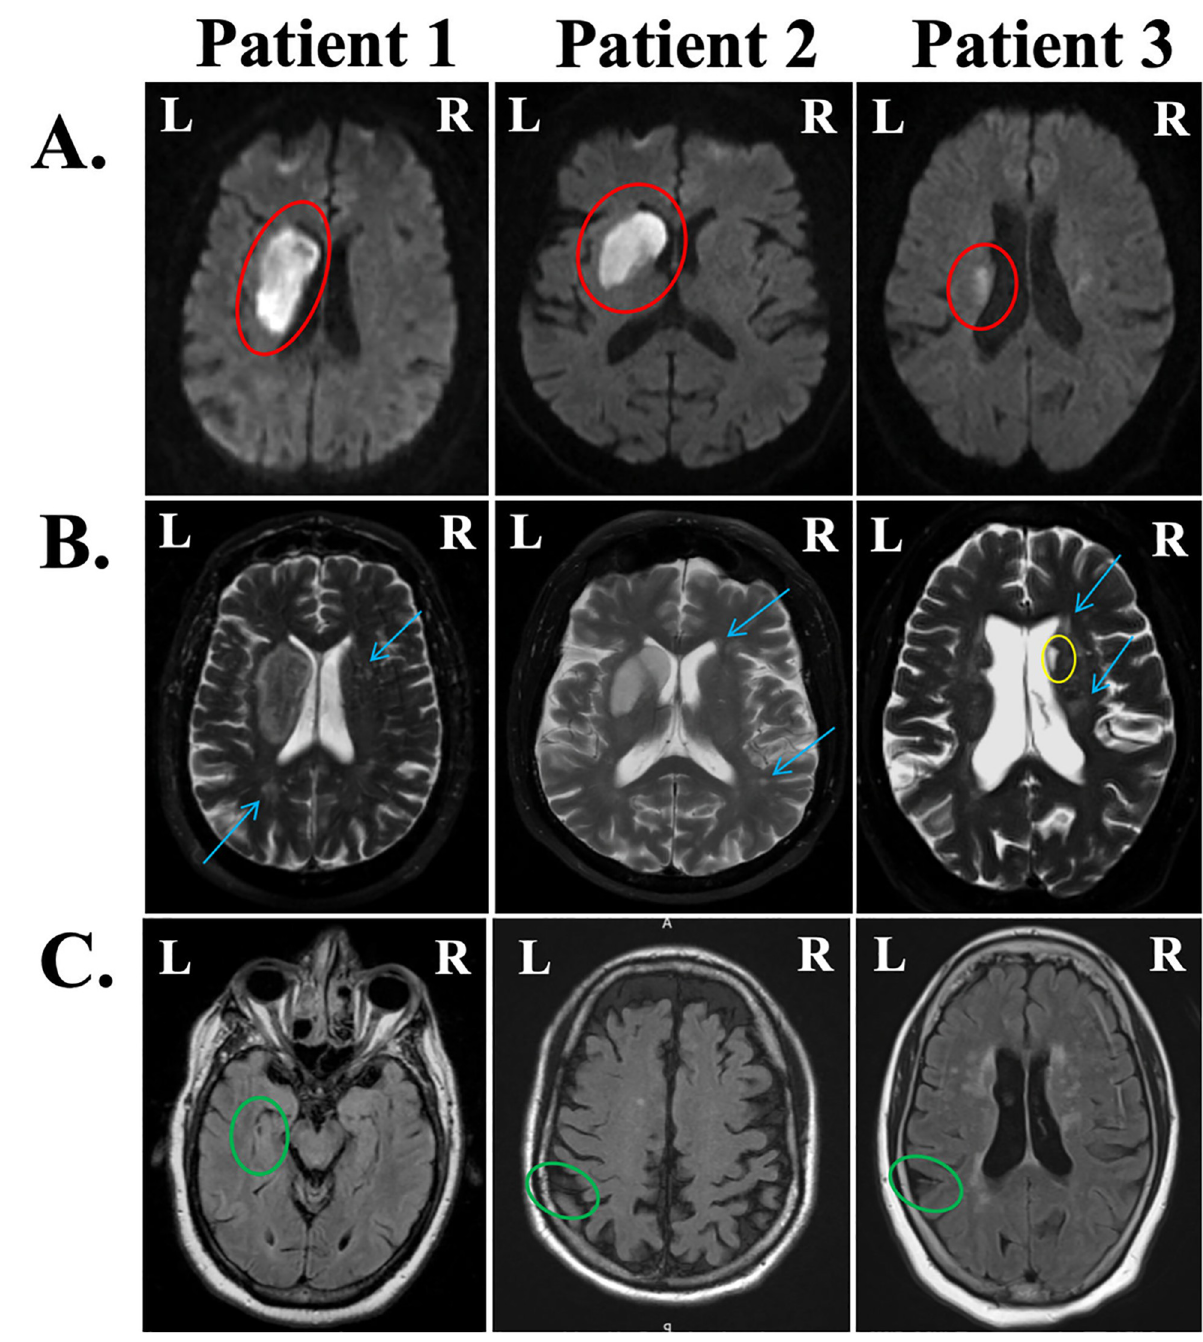
Fig 3. Clinical images from the three patients with marked language deficits in the acute phase. (A) Diffusion-weighted images (DWI) display acute lesions (red ovals). Patients 1 and 2 had lesions restricted to the basal ganglia, and Patient 3 had lesions to the basal ganglia and internal capsule. (B) T2-weighted scans were used to visually score leukoaraiosis on the Fazekas scale (blue arrows) from 0 to 3 and visualize chronic infarcts where present (yellow ovals). From left to right, periventricular hyperintensities (PVH) were scored as 2, 1, and 2; deep white matter hyperintensities (DWMH) were scored as 1, 1, and 2. (C) FLAIR hyperintense vessels (FHV) are indicative of hypoperfusion in areas surrounding infarcted tissue (green ovals). Only Patient 3 had a prior stroke. All three patients received FHV scores of 1 out of 12.